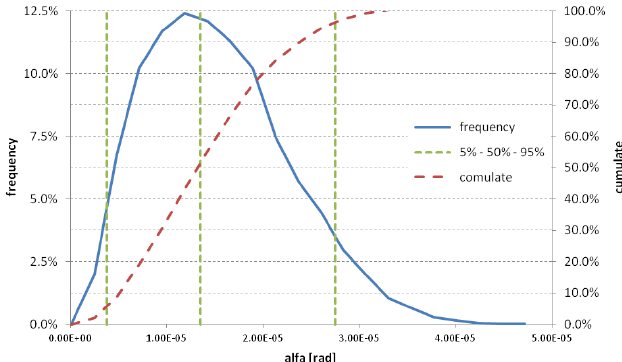
Fig. 11. Angle α , result of 10000 MCM simulations for the case R = 20 mm, H = 70 mm, L x = L y = 30